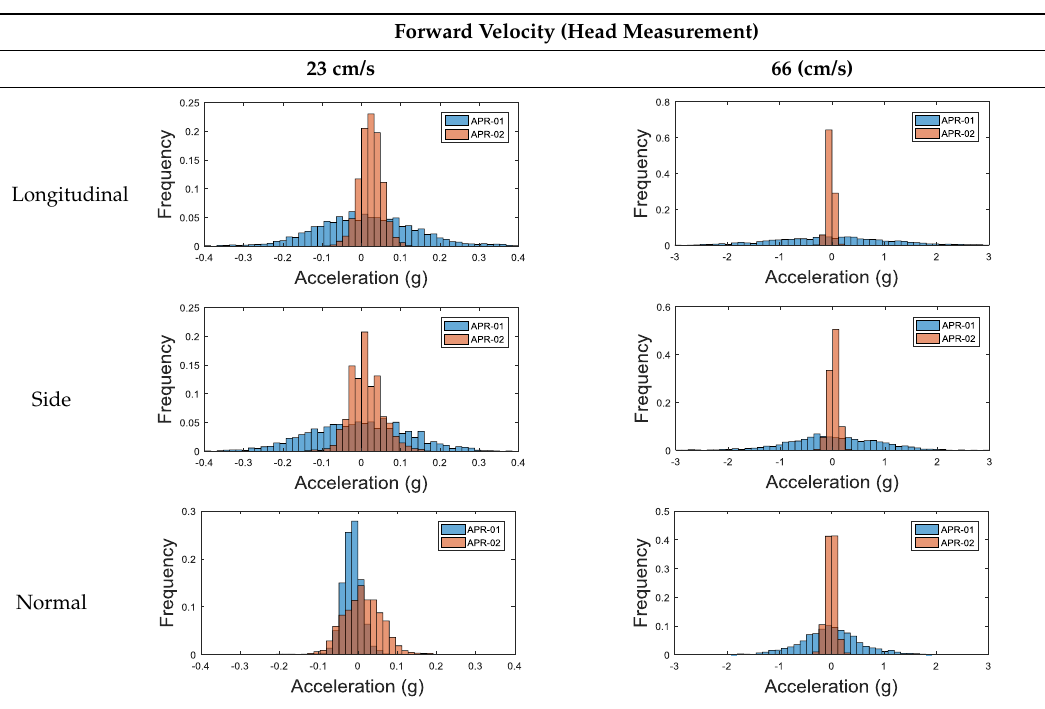
Table 8. Vibration pattern histogram measured in the head of the two APR prototypes.